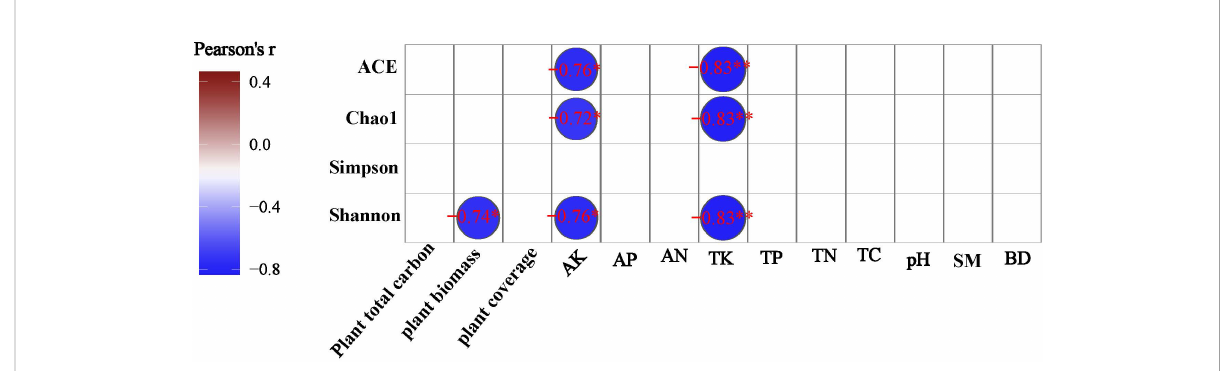
FIGURE 6 Pearson correlation analysis between alpha-diversity indices and environmental factors.